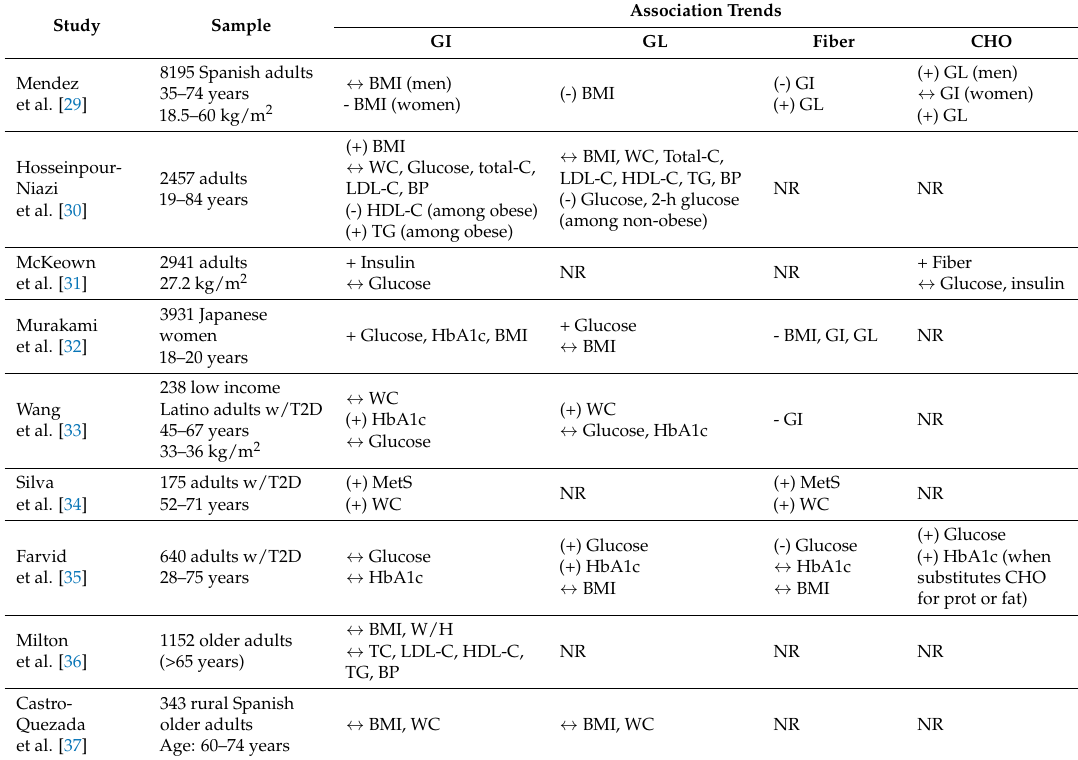
Table 3. Cross-sectional studies assessing the effects glycemic index or glycemic load on body weight 1 .